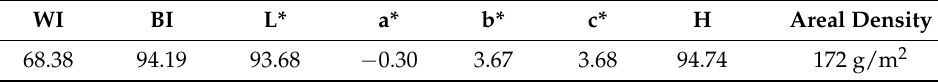
Table 1. WI, BI, color coordinates, and areal density of pretreated (NaOH- and H 2 O 2 -treated) cellulose-enriched cotton fabric.